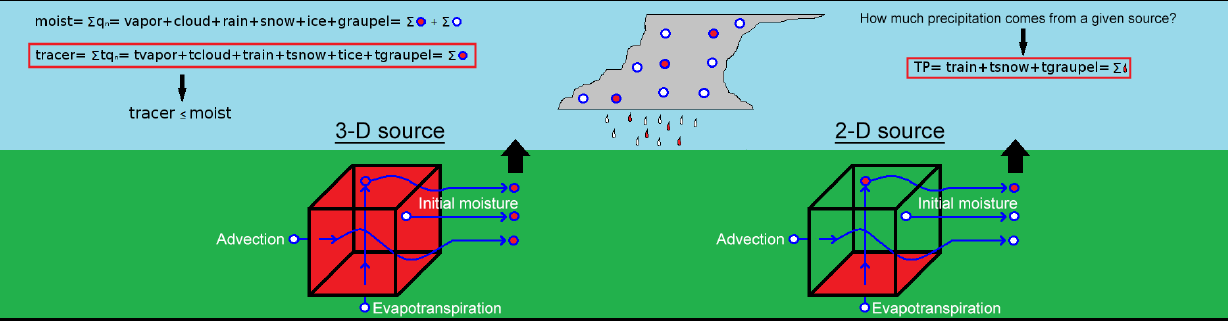
Figure 1. Sketch representing the fundamentals of the moisture tracer method, including the tagging of 3-D and 2-D moisture sources (from Insua-Costa and Miguez-Macho,